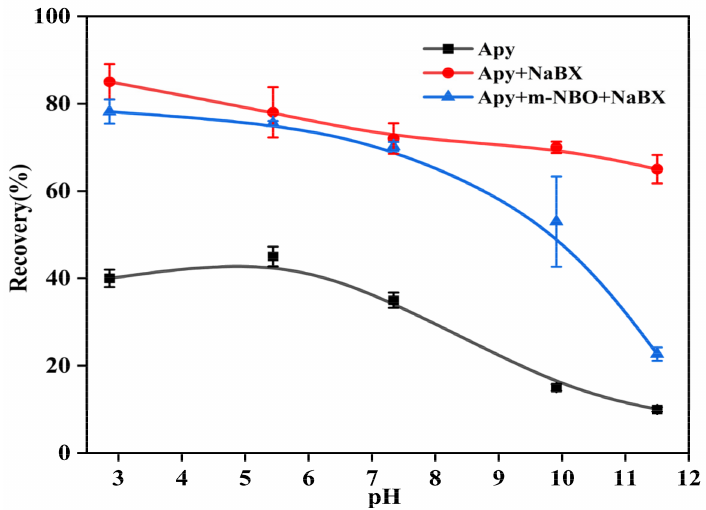
Figure 1. Effect of pH and depressants on the floatability of arsenopyrite, and error bar; C(m-NBO) = 50 mg · L − 1 and C(NaBX) = 1.6 × 10 − 3 mol · L − 1